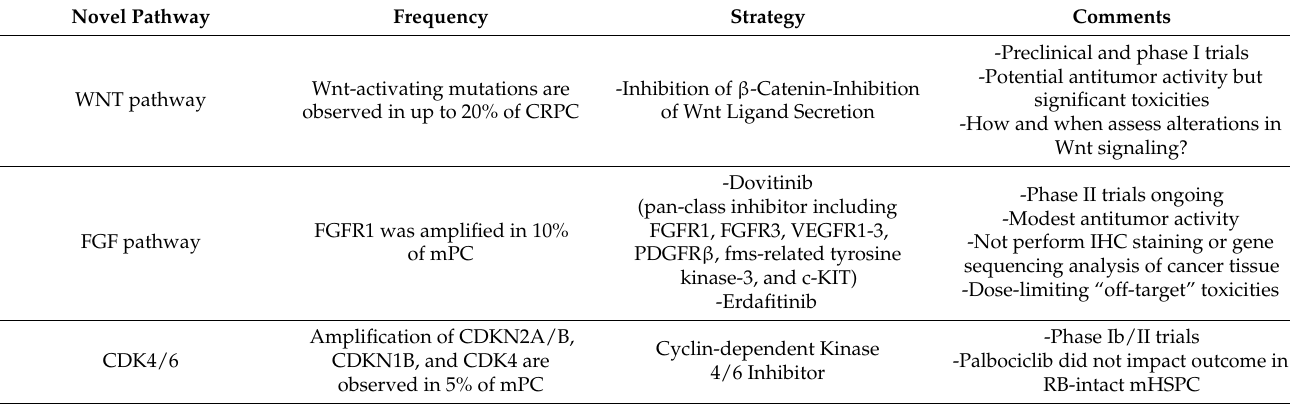
Table 6. Potential novel